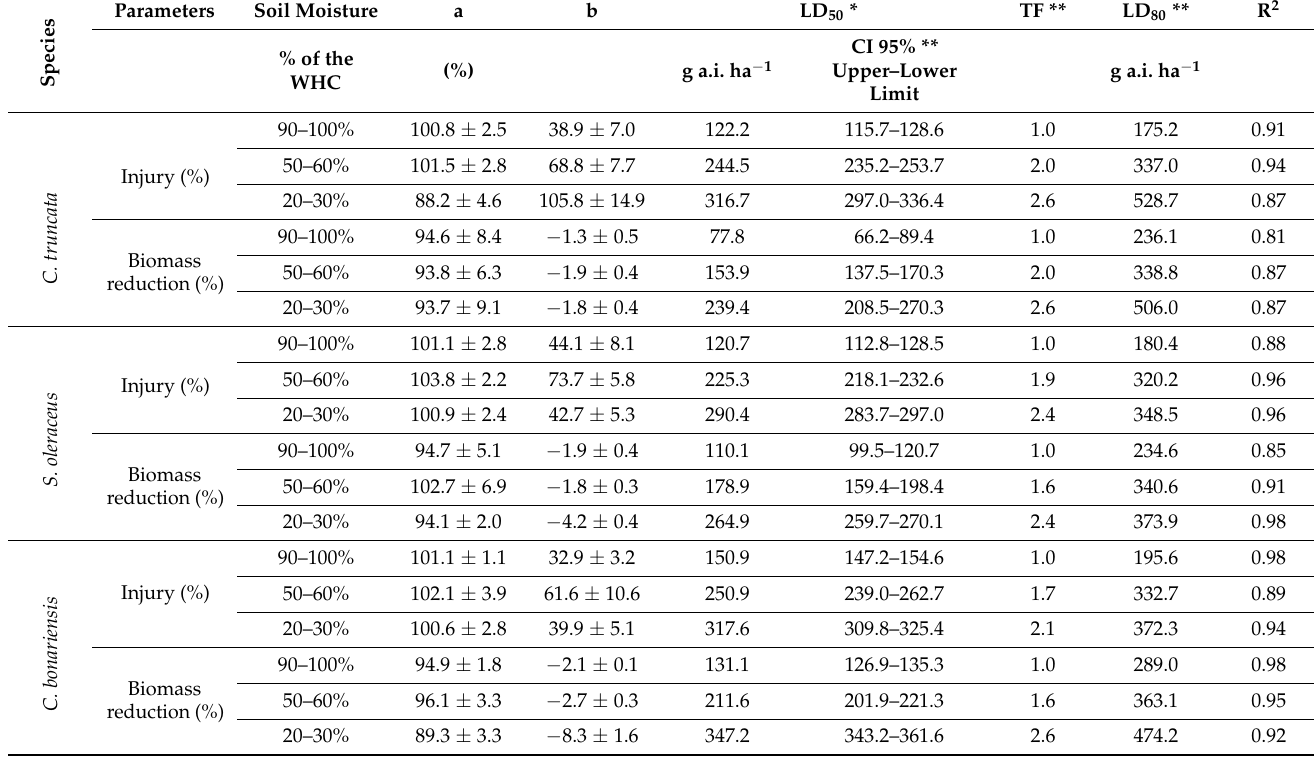
Table 1. Estimated parameter values [upper limit (a), slope (b), and LD 50 with 95% confidence intervals (CI) and the tolerance factor (TF)] from the curve fittings using Equations (1) and (2) for the herbicide injury (%) and biomass reduction (%) of C. truncata grown under soil moisture regimes, measured at 21 days after treatment in response to glyphosate application at various rates. Standard error values are in